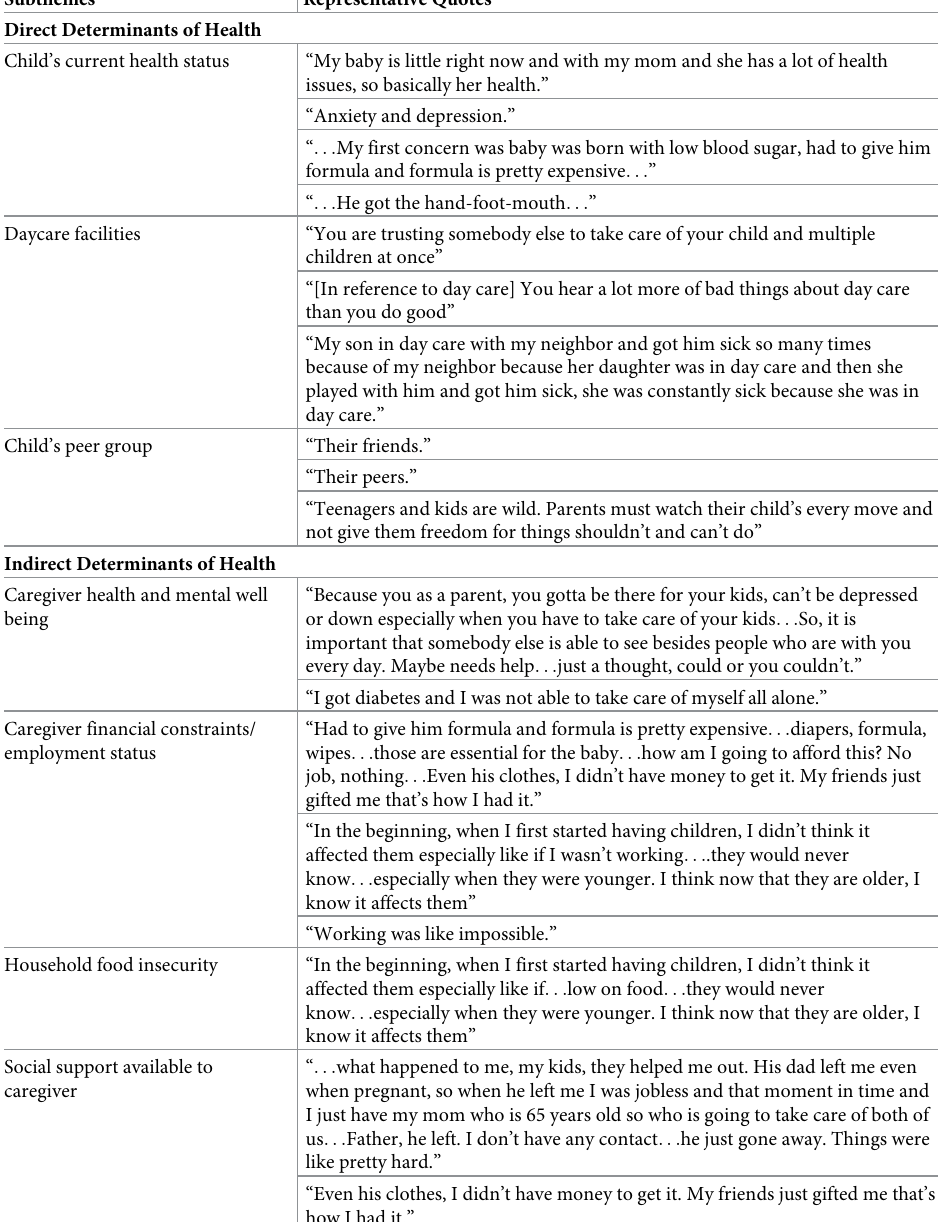
Table 2. Direct and indirect determinants of